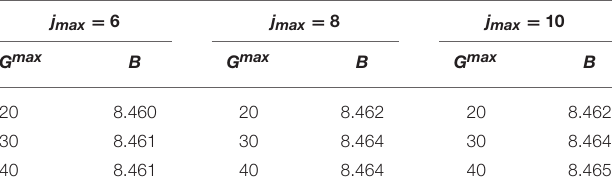
TABLE 2 | The 3 H binding energy B (in MeV) calculated with the Volkov potential model [12], using m n G max .